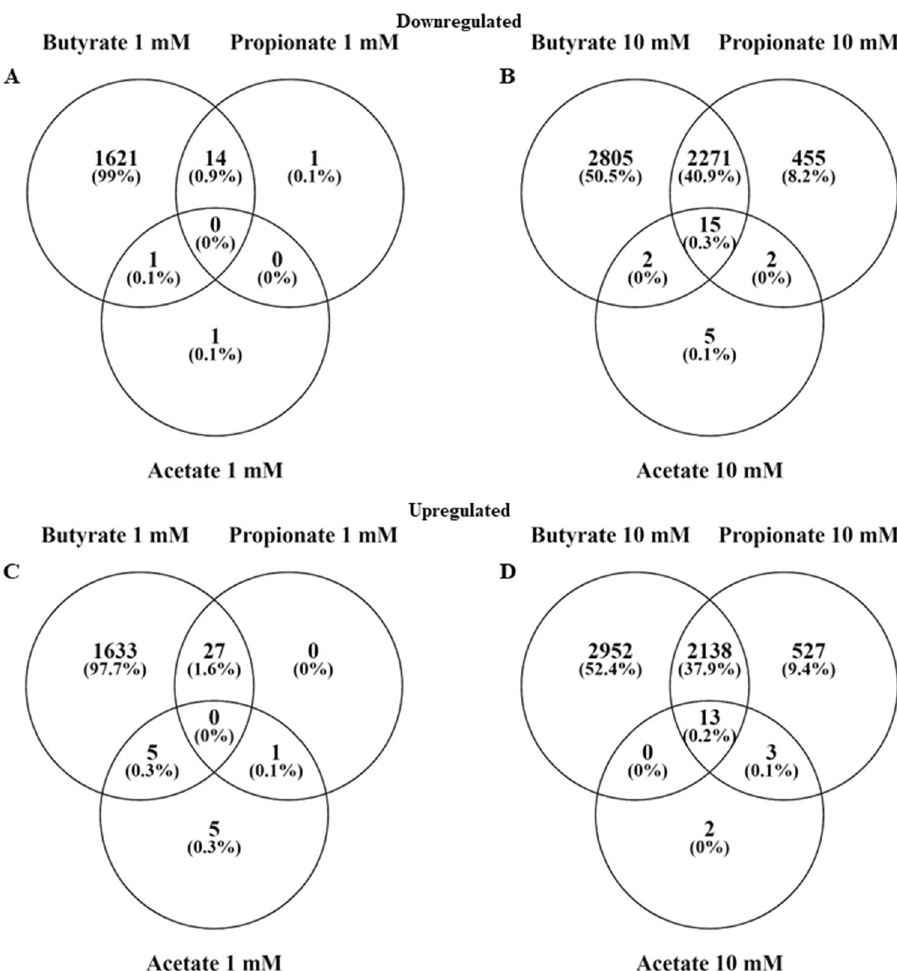
Figure 2. Venn diagrams showing the differentially expressed genes (FDR < 0.05) in induced pluripotent stem cell derived intestinal epithelial cell layers exposed to 1 or 10 mM butyrate, propionate or acetate for 24 h versus the control. ( A ) downregulated genes in IEC layers exposed to 1 mM butyrate, propionate or acetate, ( B ) downregulated genes in IEC layers exposed to 10 mM butyrate, propionate or acetate, ( C ) upregulated genes in IEC layers exposed to 1 mM butyrate, propionate or acetate, ( D ) upregulated genes in IEC layers exposed to 10 mM butyrate, propionate or